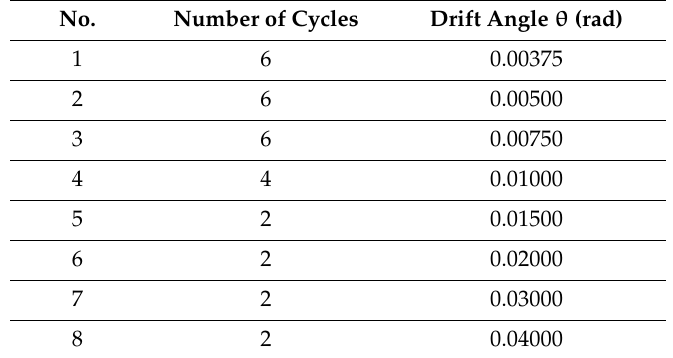
Table 2. Displacements applied, according to